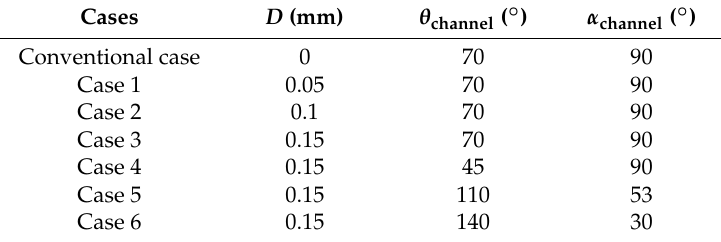
Table 1. Computational cases and parameter values considered in the present study. D is the distance from the water spreading center on the MEA surface to the MEA central line, representing the initial water droplet location; θ channel is the channel surface contact angle; and α channel is the channel surface sliding angle, representing the channel surface wettability. Cases D (mm) θ channel ( ◦ ) α channel ( ◦ ) Conventional